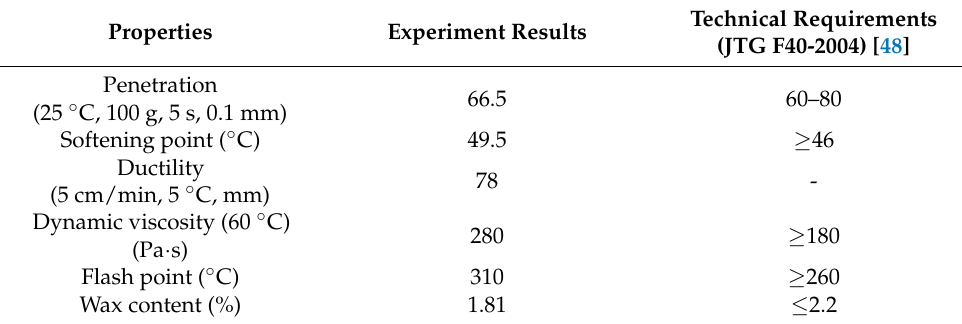
Table 2. Requirements of